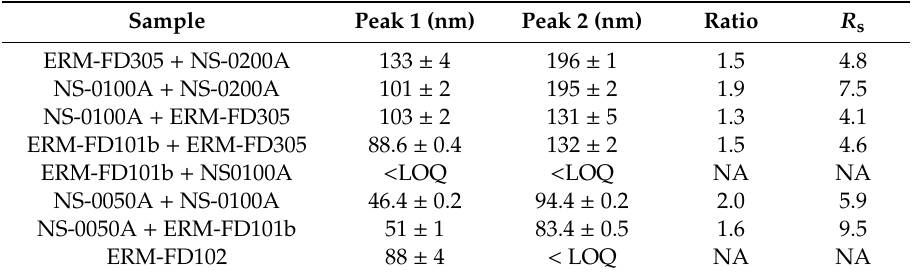
Table 7. Stokes diameters of local maxima (mean ± standard deviation) and resolution values